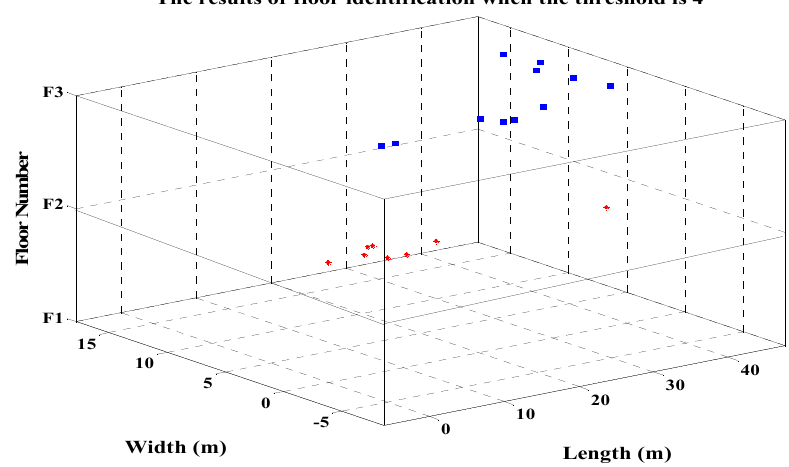
Figure 13. Floor identification results of the moving receiver when the threshold is 4.